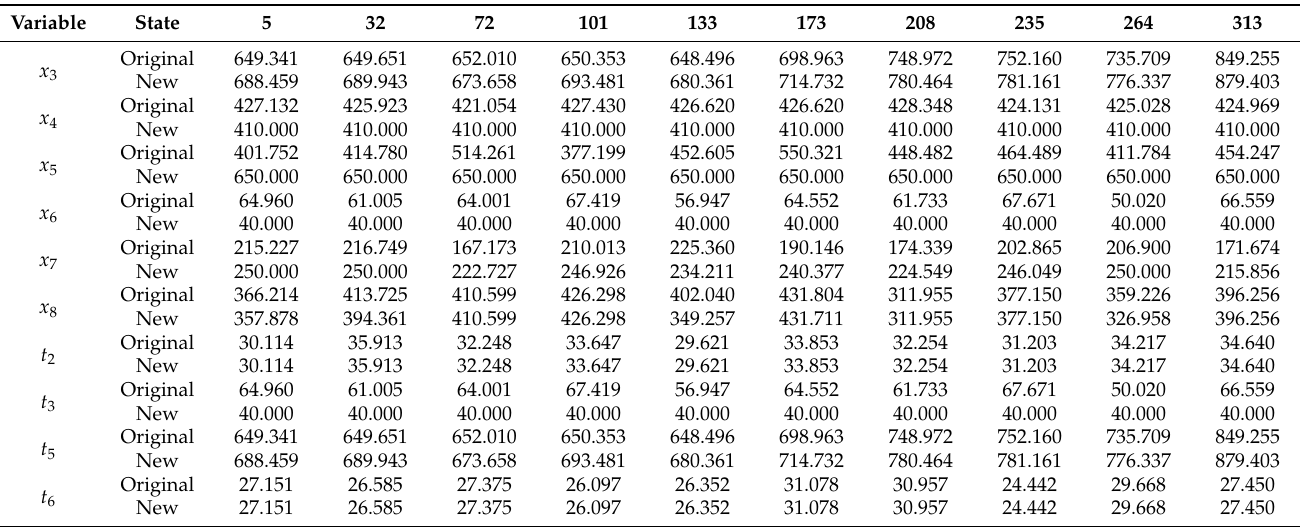
Figure 4. Comparison diagram of product RON before and after optimization. The operation scheme of the main variables of some samples whose loss reduction was greater than 30% is provided in Table 11. Table 11. Operation scheme of some